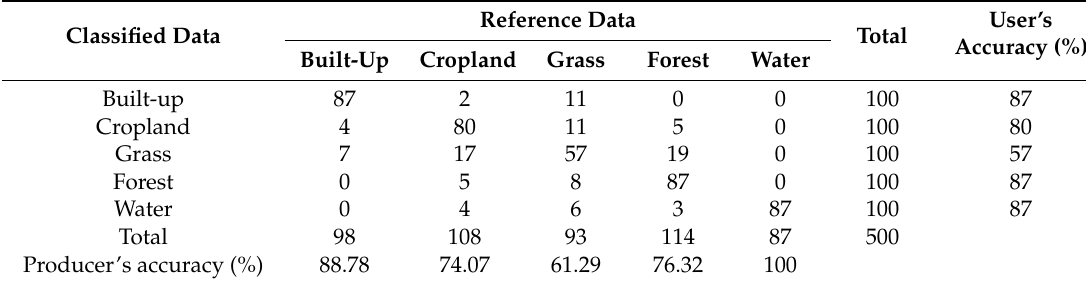
Table A2. Error matrix for the classified 2005 LULC map.